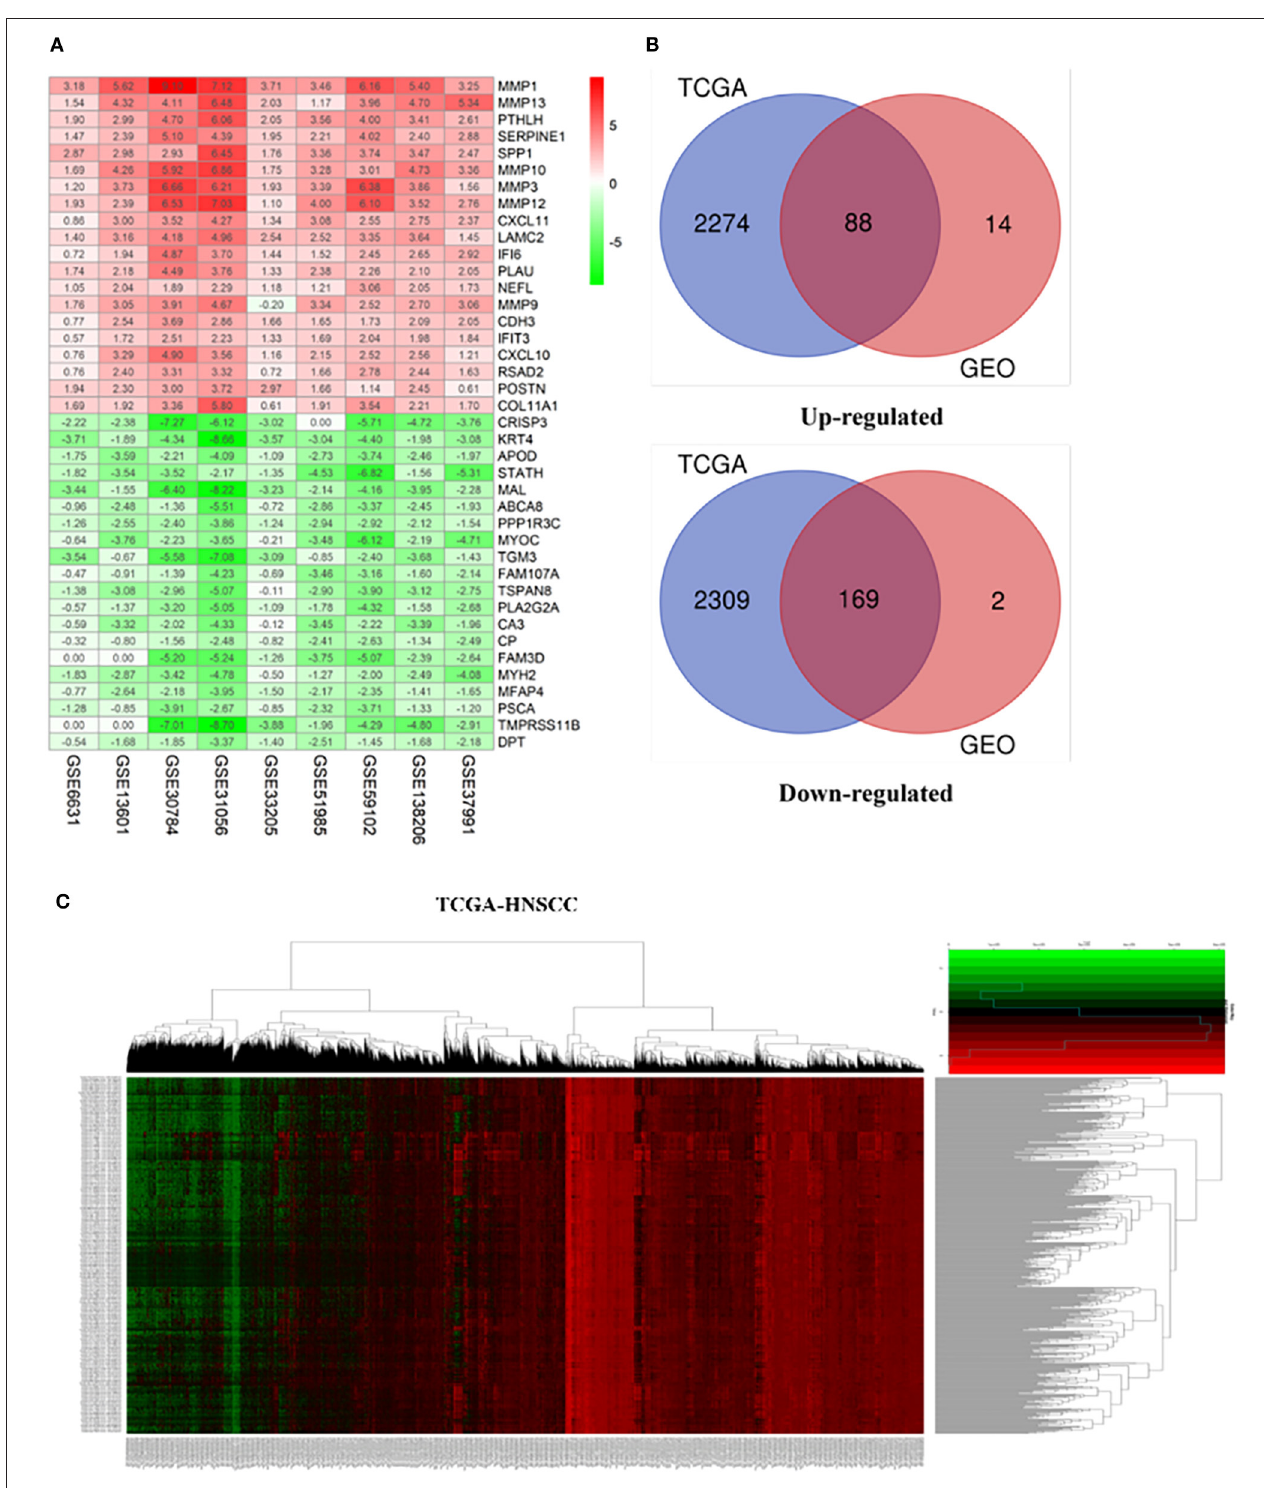
FIGURE 2 | Integrated analysis of differentially expressed genes (DEGs). (A) Shows heat maps of the top 20 up-regulated and down-regulated differential genes screened from 9 GEO datasets based on “RobustRankAggre” method. (B) Venn diagram of the intersection of TCGA and GEO differential genes. (C) The heatmap of differential genes in the TCGA-HNSCC